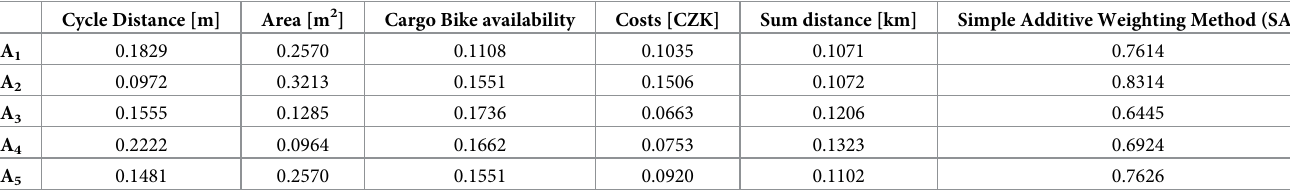
Table 19. Weighted decision-making